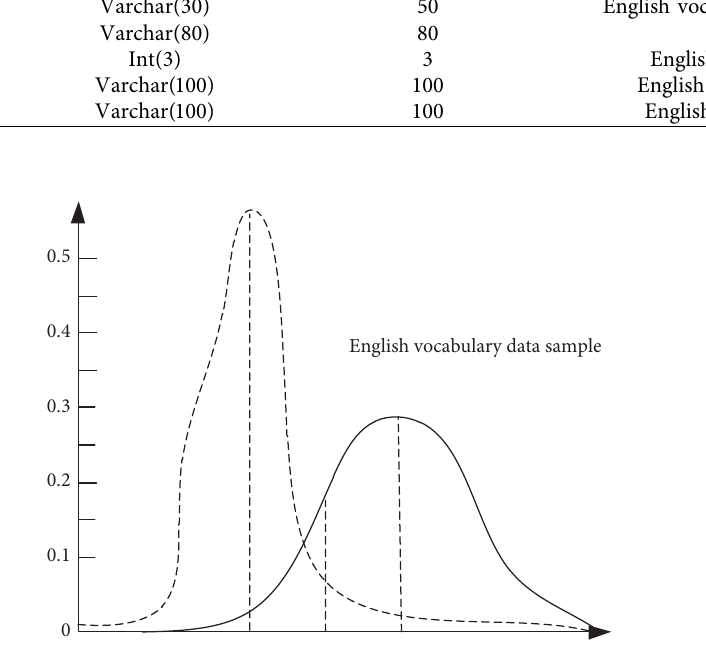
Figure 4: Normal distribution status between university English lexical data in the